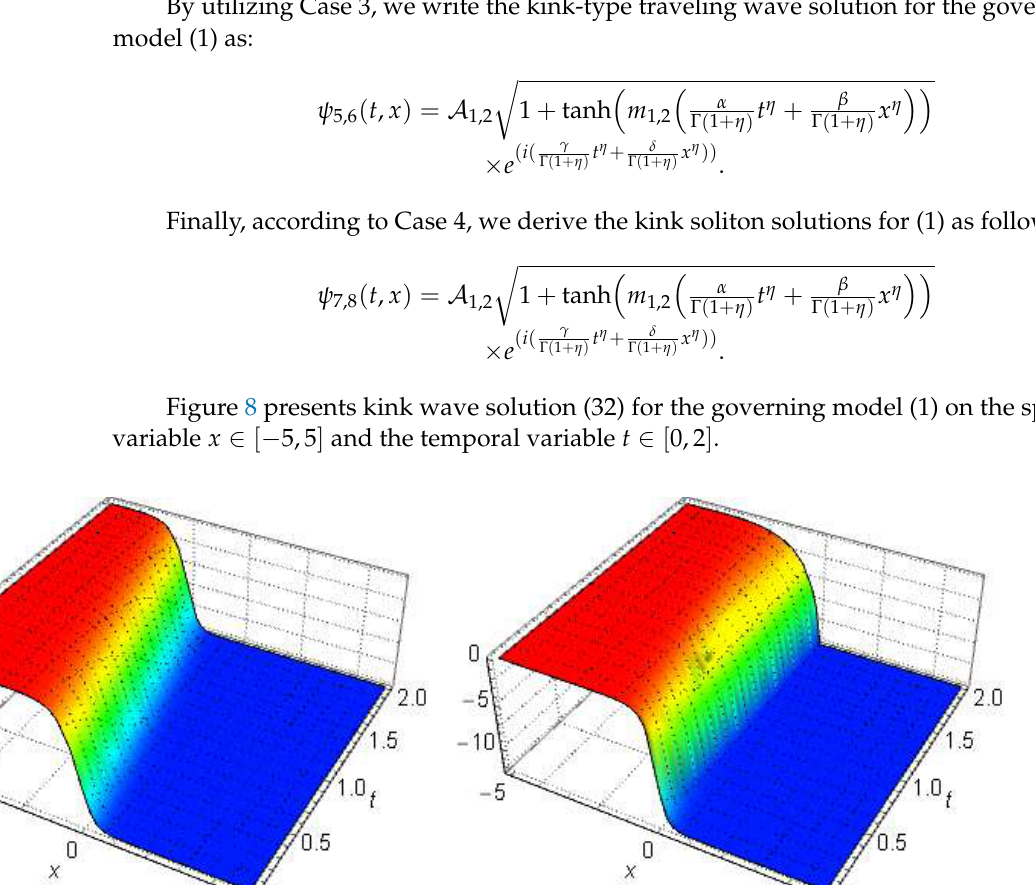
Figure 8. Kink soliton solution | ψ 1 ( x , t ) | in (32) for (1) at a 1 = 0.1, a 2 = 1, a 4 = 0.05, q 1 = 0.1, α = 0.1, β = 0.1, γ = 0.1, δ = 3: ( a ) integer derivative order η = 1; ( b ) fractional derivative order 0.82 .